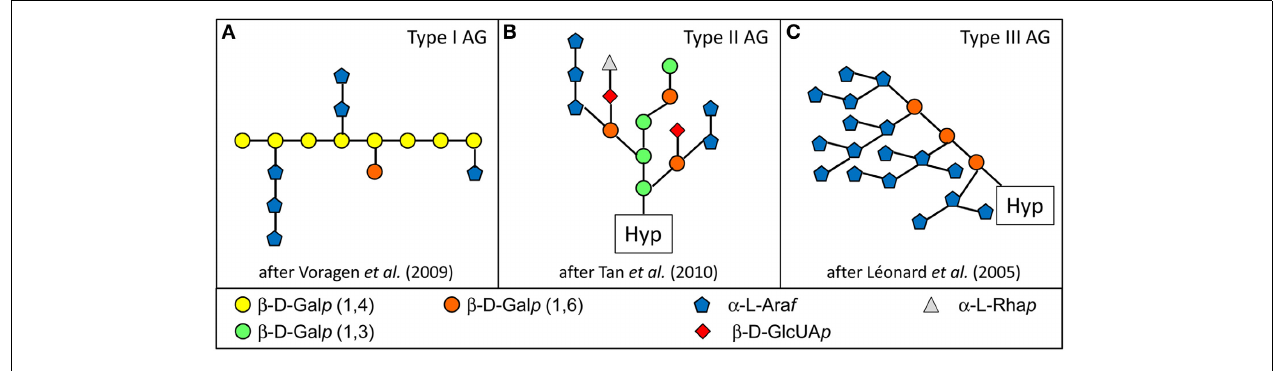
FIGURE 1 | The three main types of AGs. One of the main differences between these AG types consist in the type of linkages between Gal residues of the main chain: β -1,4 in type I AG (A) ; β -1,3 and β -1,6 in type II AG